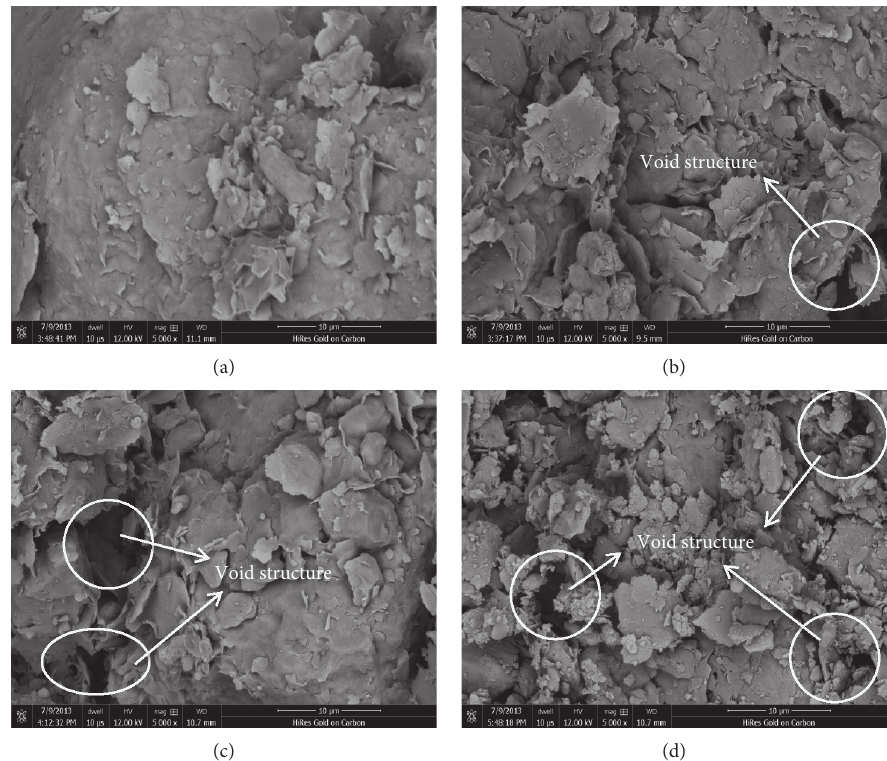
Figure 8: SEM images of untreated specimens under different W-D cycles: (a) 0 W-D cycle; (b) 1 W-D cycle; (c) 5 W-D cycles; (d) 20 W-D cycles.